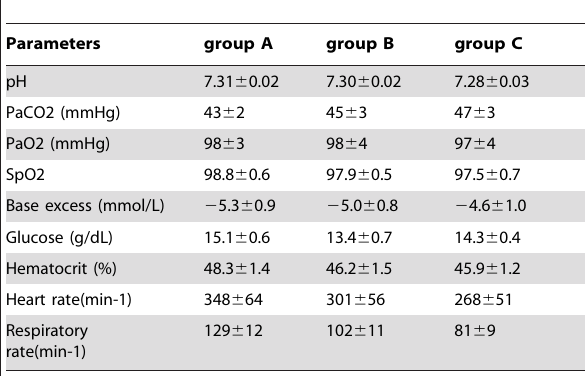
Table 2. Blood gas values, Heart rate and Respiratory